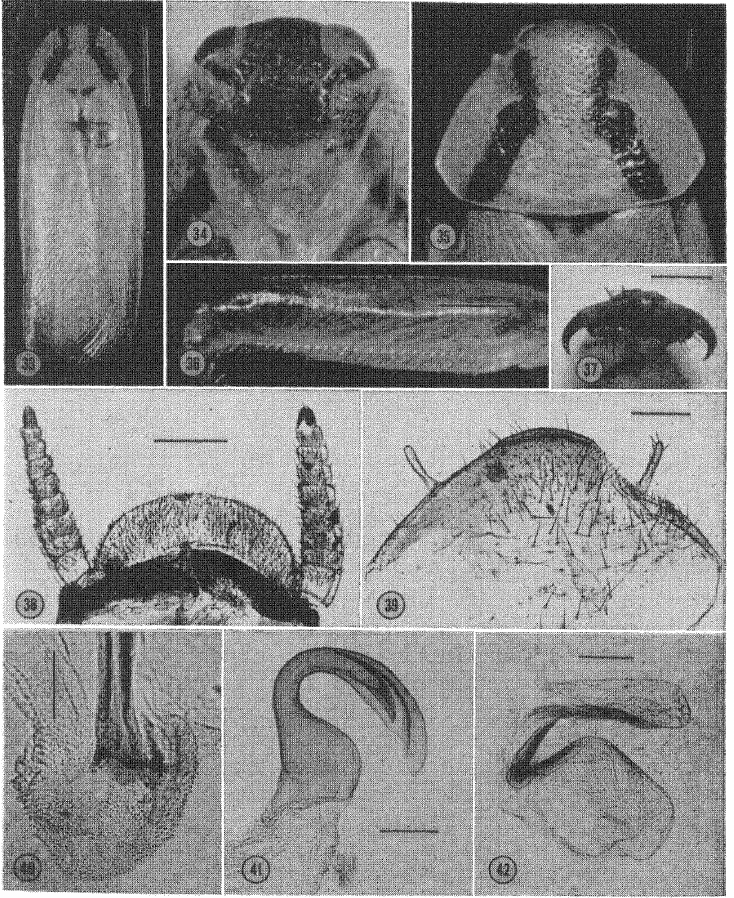
Figs. 33-42. Gurneya obliqua (Walker). Holotype 6’ of Ischno#tera (?) obliqua Walker. All structures shown in figs, 34-42 are from the type. 33. Adult. 34. Head (frontal view). 35. Pronotum. 36. Front femur (an- terior surface). 37. Tarsal claws and arolium of prothoraeie leg (end view). 38. Supra-anal plate and eerei; the dark structures are paraproets seen through the cleared tergite (dorsal). 39. Subgenital plate (ventral). 40-42. Genital phallomeres" 40. Apex of L2vm, and preputial membrane. 41. R2. 42. L1. (Specimens shown in figs. 38-42 are KOH treated, cleared, flattened preparations on a slide); (seale" fig. 33- ram; figs. 34-35 ram; figs. 36, 38-39 0.5 mm; fig. 37 0.25 ram; fig. 40 0.1 ram; figs. 41-42 0.2